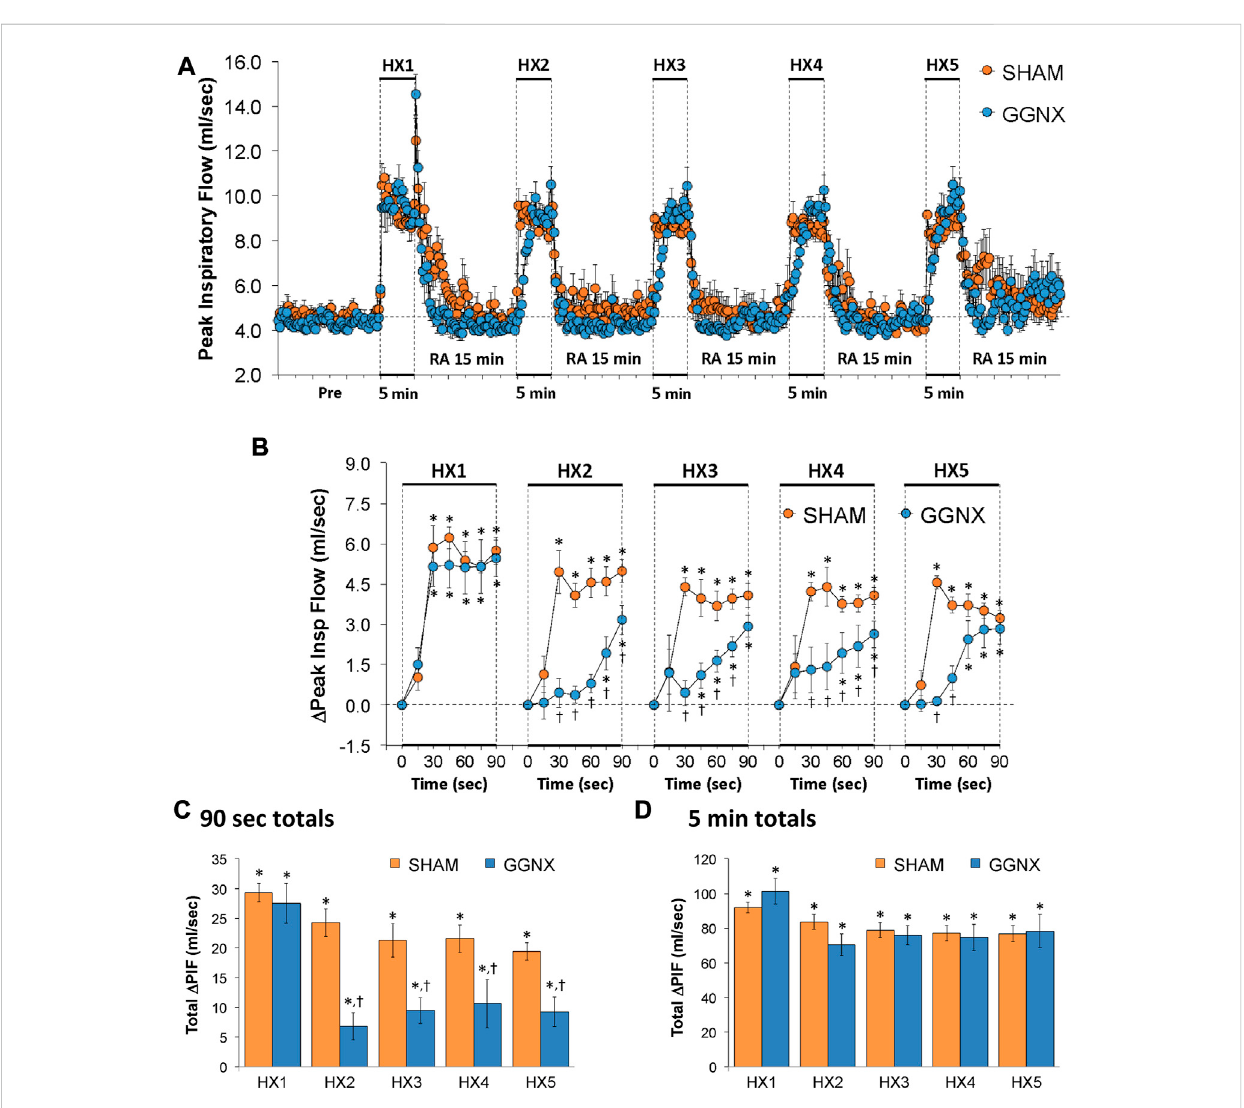
FIGURE 9 (A) Peak Inspiratory Flow (Peak Insp Flow; PIF) values in sham-operated (SHAM) rats and in rats with bilateral ganglioglomerular nerve transection (GGNX)before(Pre)andduring fi